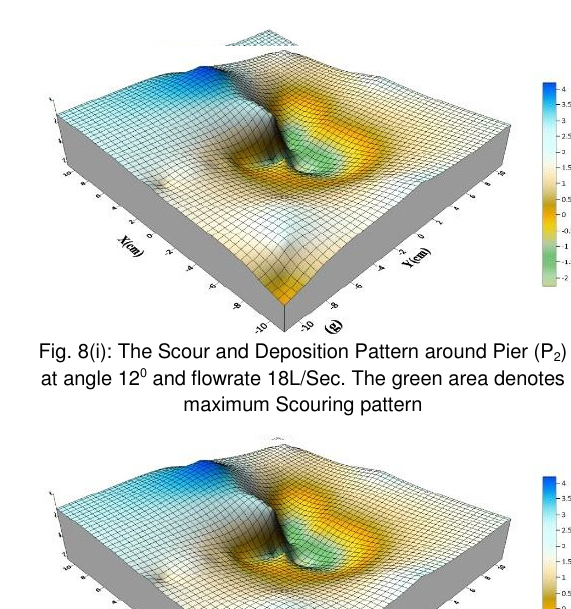
Fig. 8(h): The Scour and Deposition Pattern around Pier (P 2 ) at angle 12 0 and flowrate 14L/Sec.